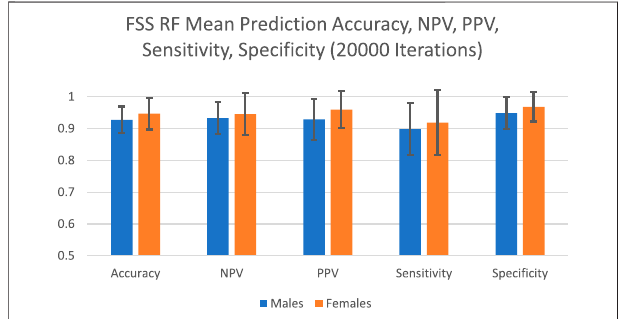
FIGURE 1 | FSS random forest prediction accuracy, NPV, PPV, sensitivity, and speci fi city for 20,000